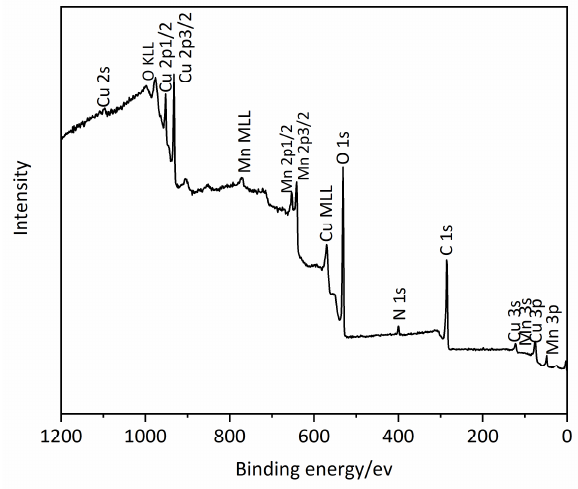
Figure 4. The X-ray photoelectron spectroscopy (XPS) spectrum of elements of Mn 0.1 Cu 0.9 -MOF.